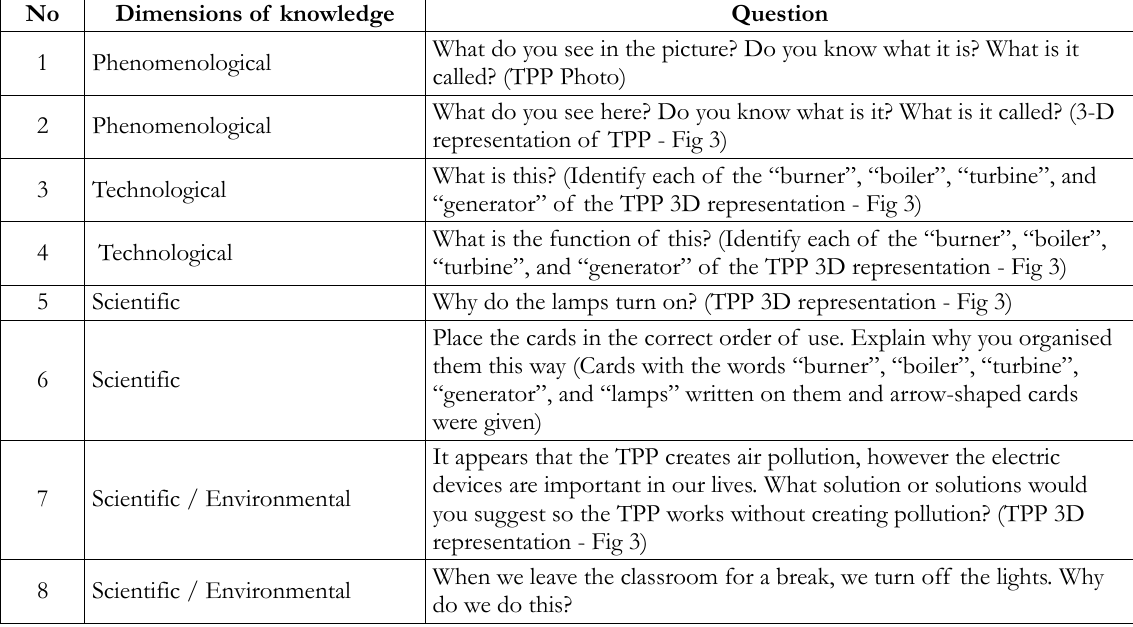
Table 2. The content of the interview